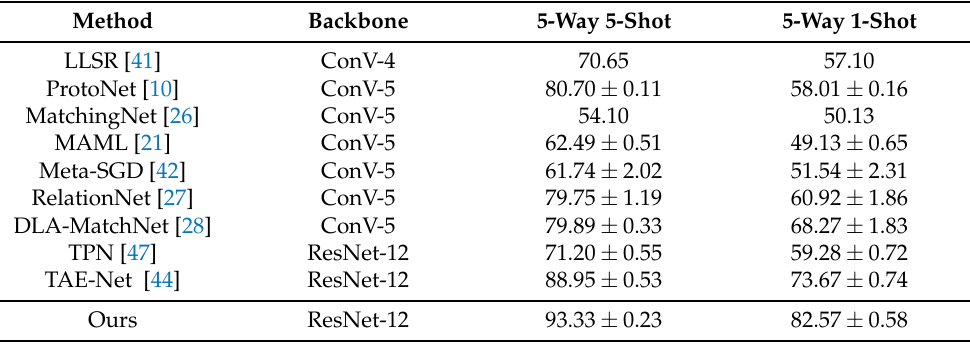
Table 4. The few-shot classification accuracies with 95% confidence intervals over 600 episodes in the WHU-RS19